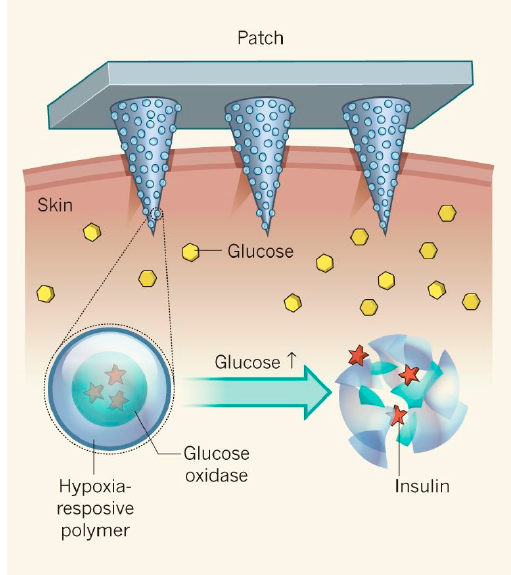
Figure 8. Illustration of an insulin patch and stimuli-responsive mechanism for transdermal insulin delivery (reproduced with permission from Reference [106]).